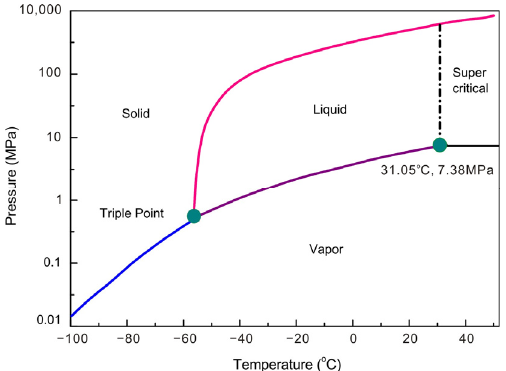
Figure 1. Phase state of CO 2 with varying temperature and pressure (modified from Holliday et al.